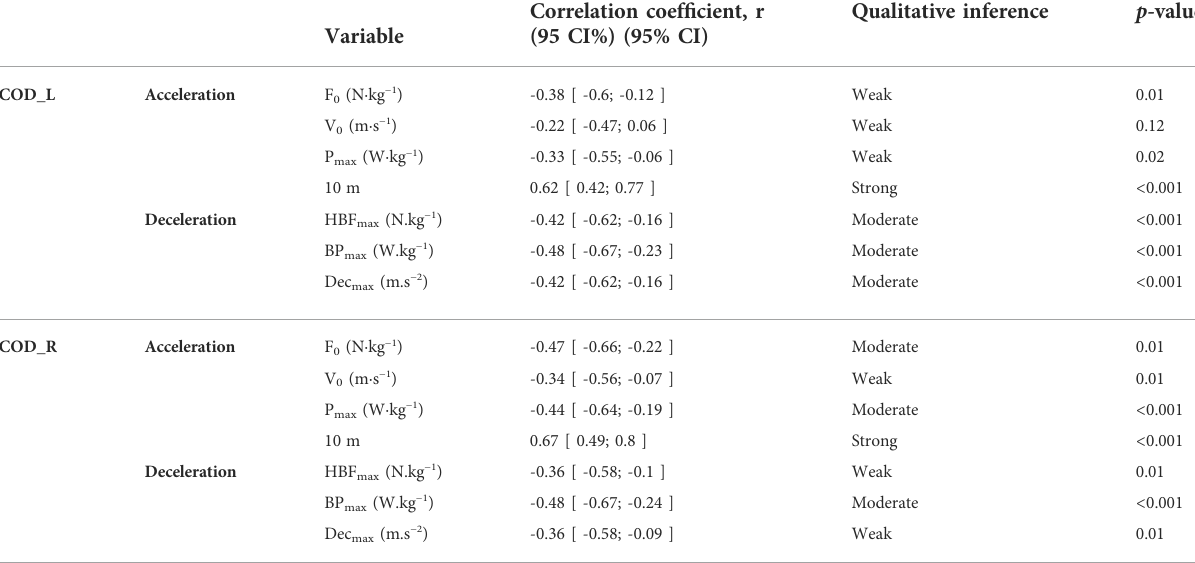
TABLE 2 Associations between acceleration and deceleration mechanical parameters and COD performance on left side (COD_L) and right side (COD_R) for female players. F 0 : maximal theoretical force; V 0 : maximal theoretical velocity; P max : maximal power; 10 m: 10 m split time. HBF max : maximum braking force; HBP max : maximum braking power; Dec max maximum deceleration.